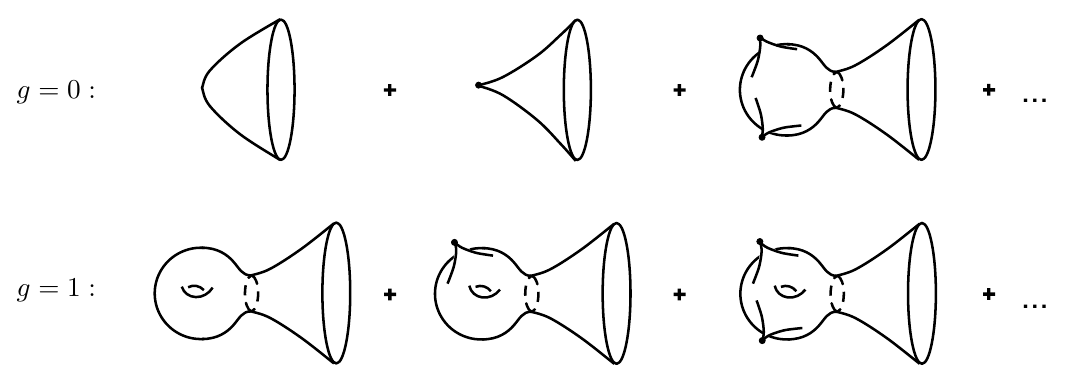
(cid:10) (cid:11) Z ( (cid:12) ) , as in (3.5) with